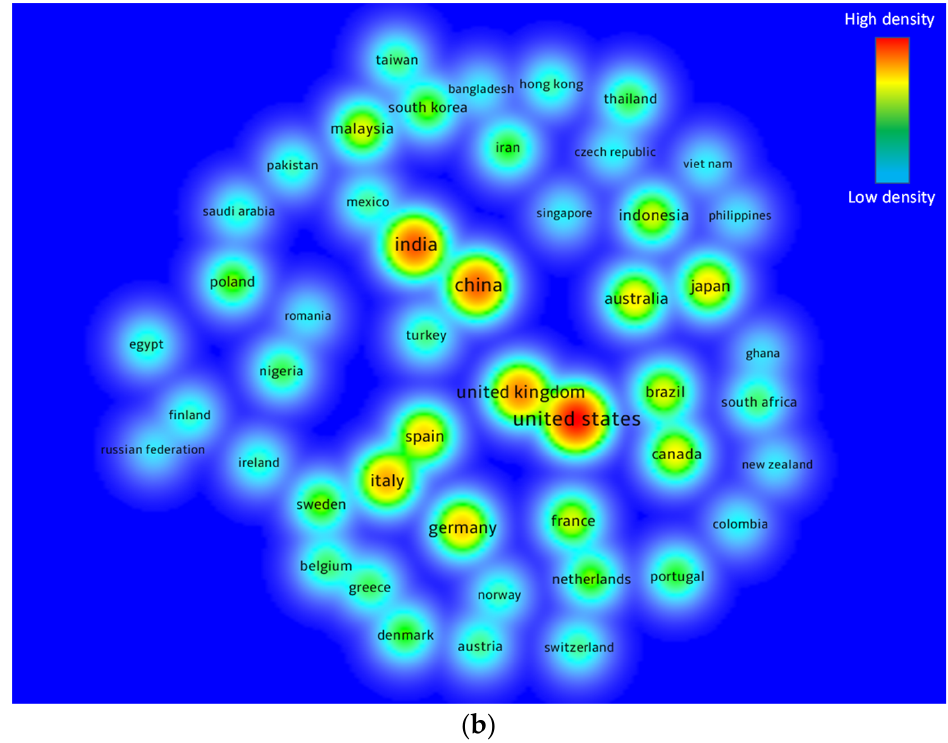
Figure 10. Science mapping of the top contributing countries: ( a ) Network visualization: box size is proportional to the number of publications by a particular country, and different colors show distinct clusters created based on the pattern of co-citations of countries in published articles; ( b ) Density visualization.